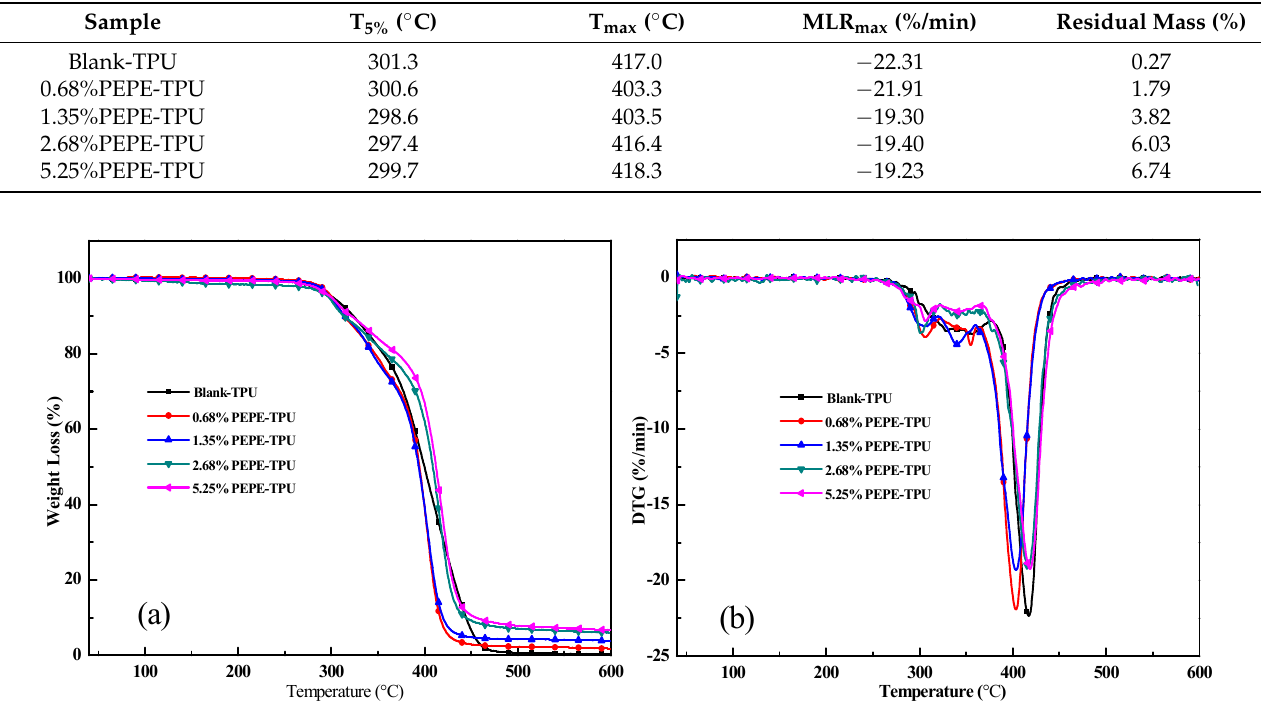
Figure 2. TG curves of TPU with PEPE in the N 2 ; ( a ) weight and ( b ) weight loss rate. Table 3. TG data of flame-retardant TPU with PEPE.